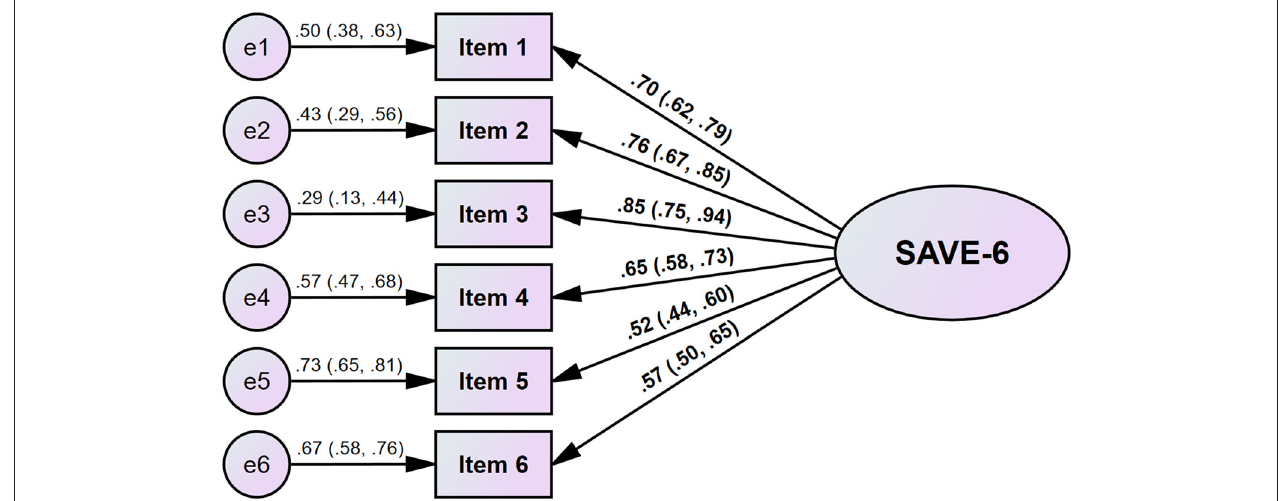
FIGURE 1 | Factor structure of the Bangla version of the SAVE-6 scale.